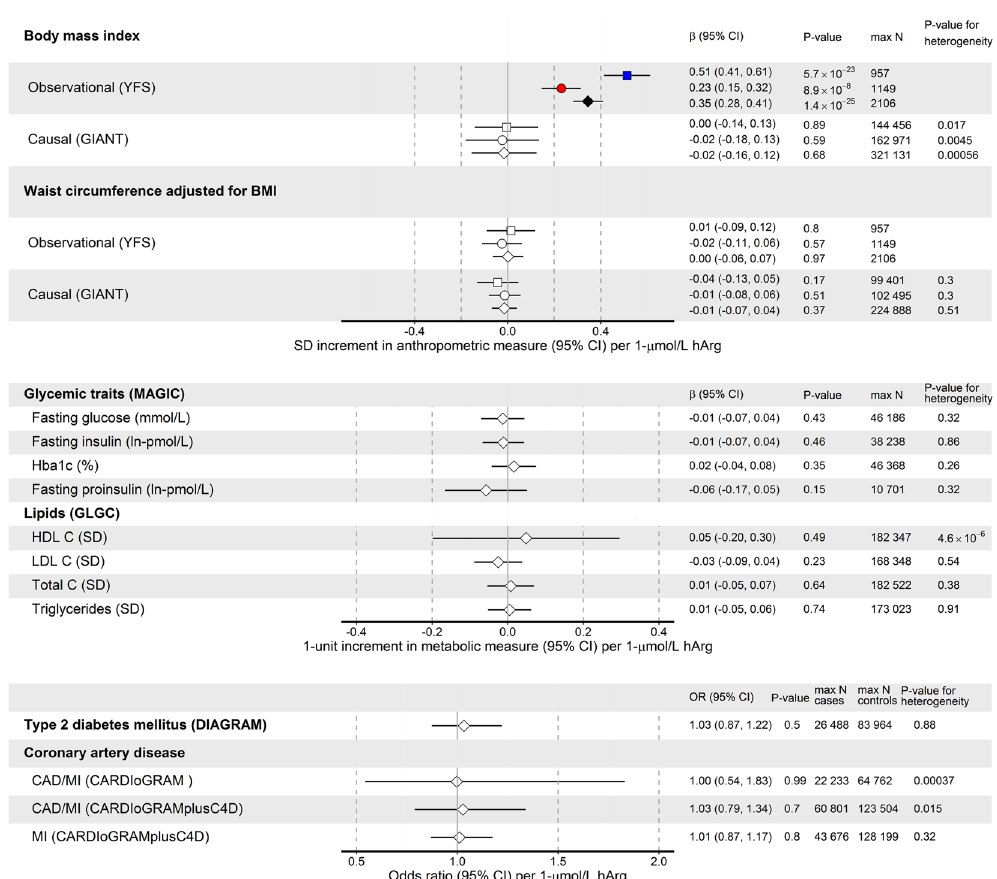
hArg levels compared to non-diabetic controls 8 , and, in patients with T2DM undergoing maintenance haemodi- alysis, low hArg levels correlated with longer duration of T2DM 1 .